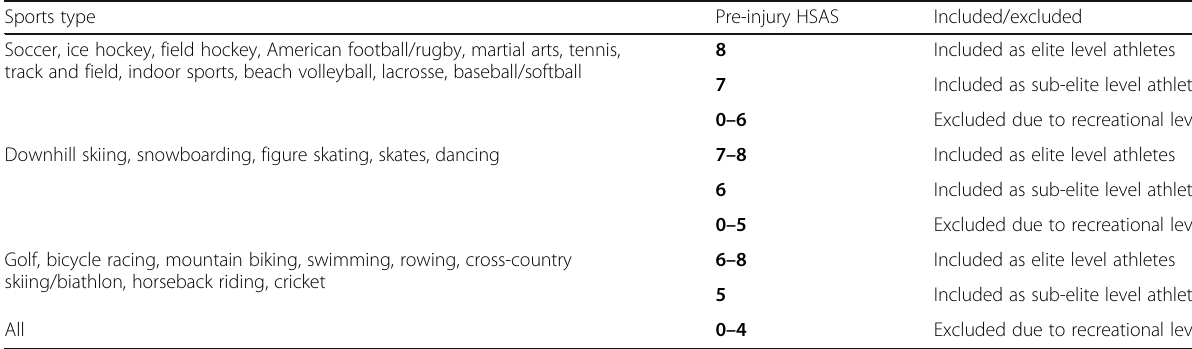
Table 1 Included and excluded athletes relative to their sport type and pre-injury HSAS score Sports